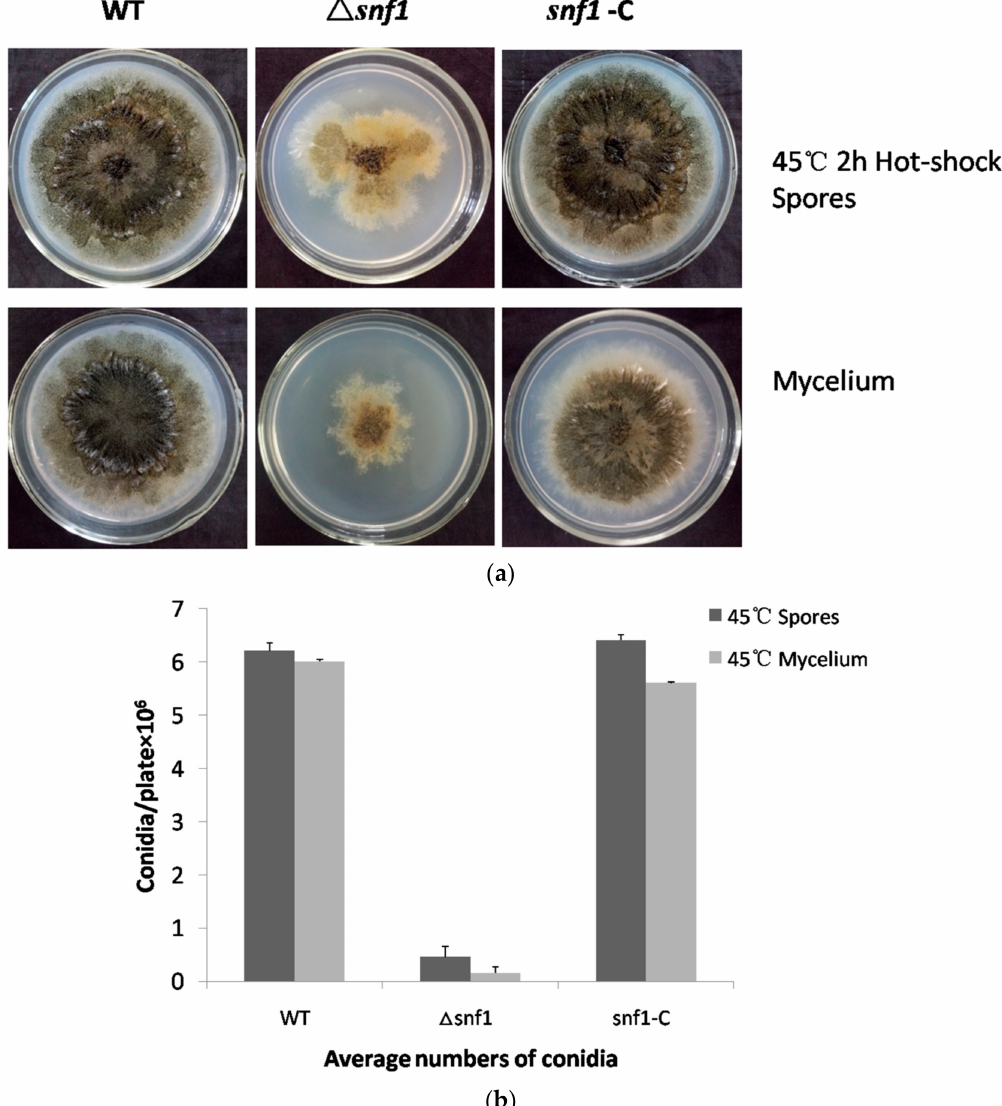
Figure 5. Sensitivity of ∆ snf1 to heat shock. ( a ) Fresh spores and mycelium were incubated in sterile ddH2O at 45 ◦ C for 2 h. Equal numbers of conidia (~5 × 10 4 ) or equal volume of mycelium from NK17, ∆ snf1 and the complementation strain snf1 -C were inoculated on PDA at 28 ◦ C for seven days. ∆ snf1 showed a high sensitivity to heat shock. Conidia without heat-shocked served as control; ( b ) The number of conidia produced by NK17, ∆ snf1 and the complementation strain snf1 -C was determined in every medium and triplicate PDA plates for each strain were incubated at 28 ◦ C for 168 h and used for quantification. Error bars represent standard